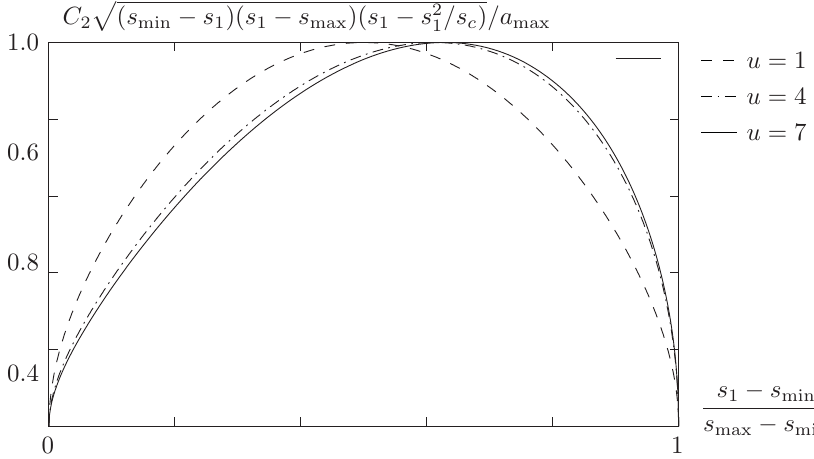
Figure 7: Normalized variation in the contact zone half-width for different gear ratios ranging from u = 7 to u = 1, the load is assumed to have a parabolic variation along the contact line. The plot is made for a pinion gear with n z = 17, β = π/ 9 and α = π/ 9.